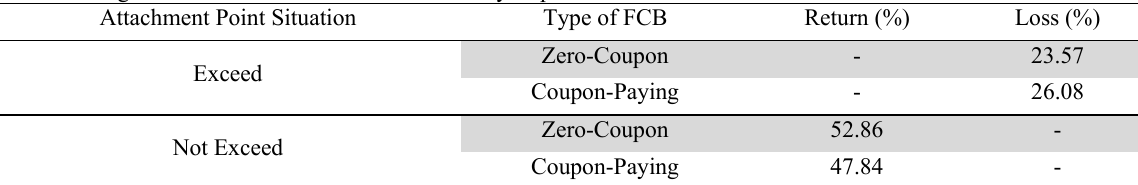
Attachment Point Situation